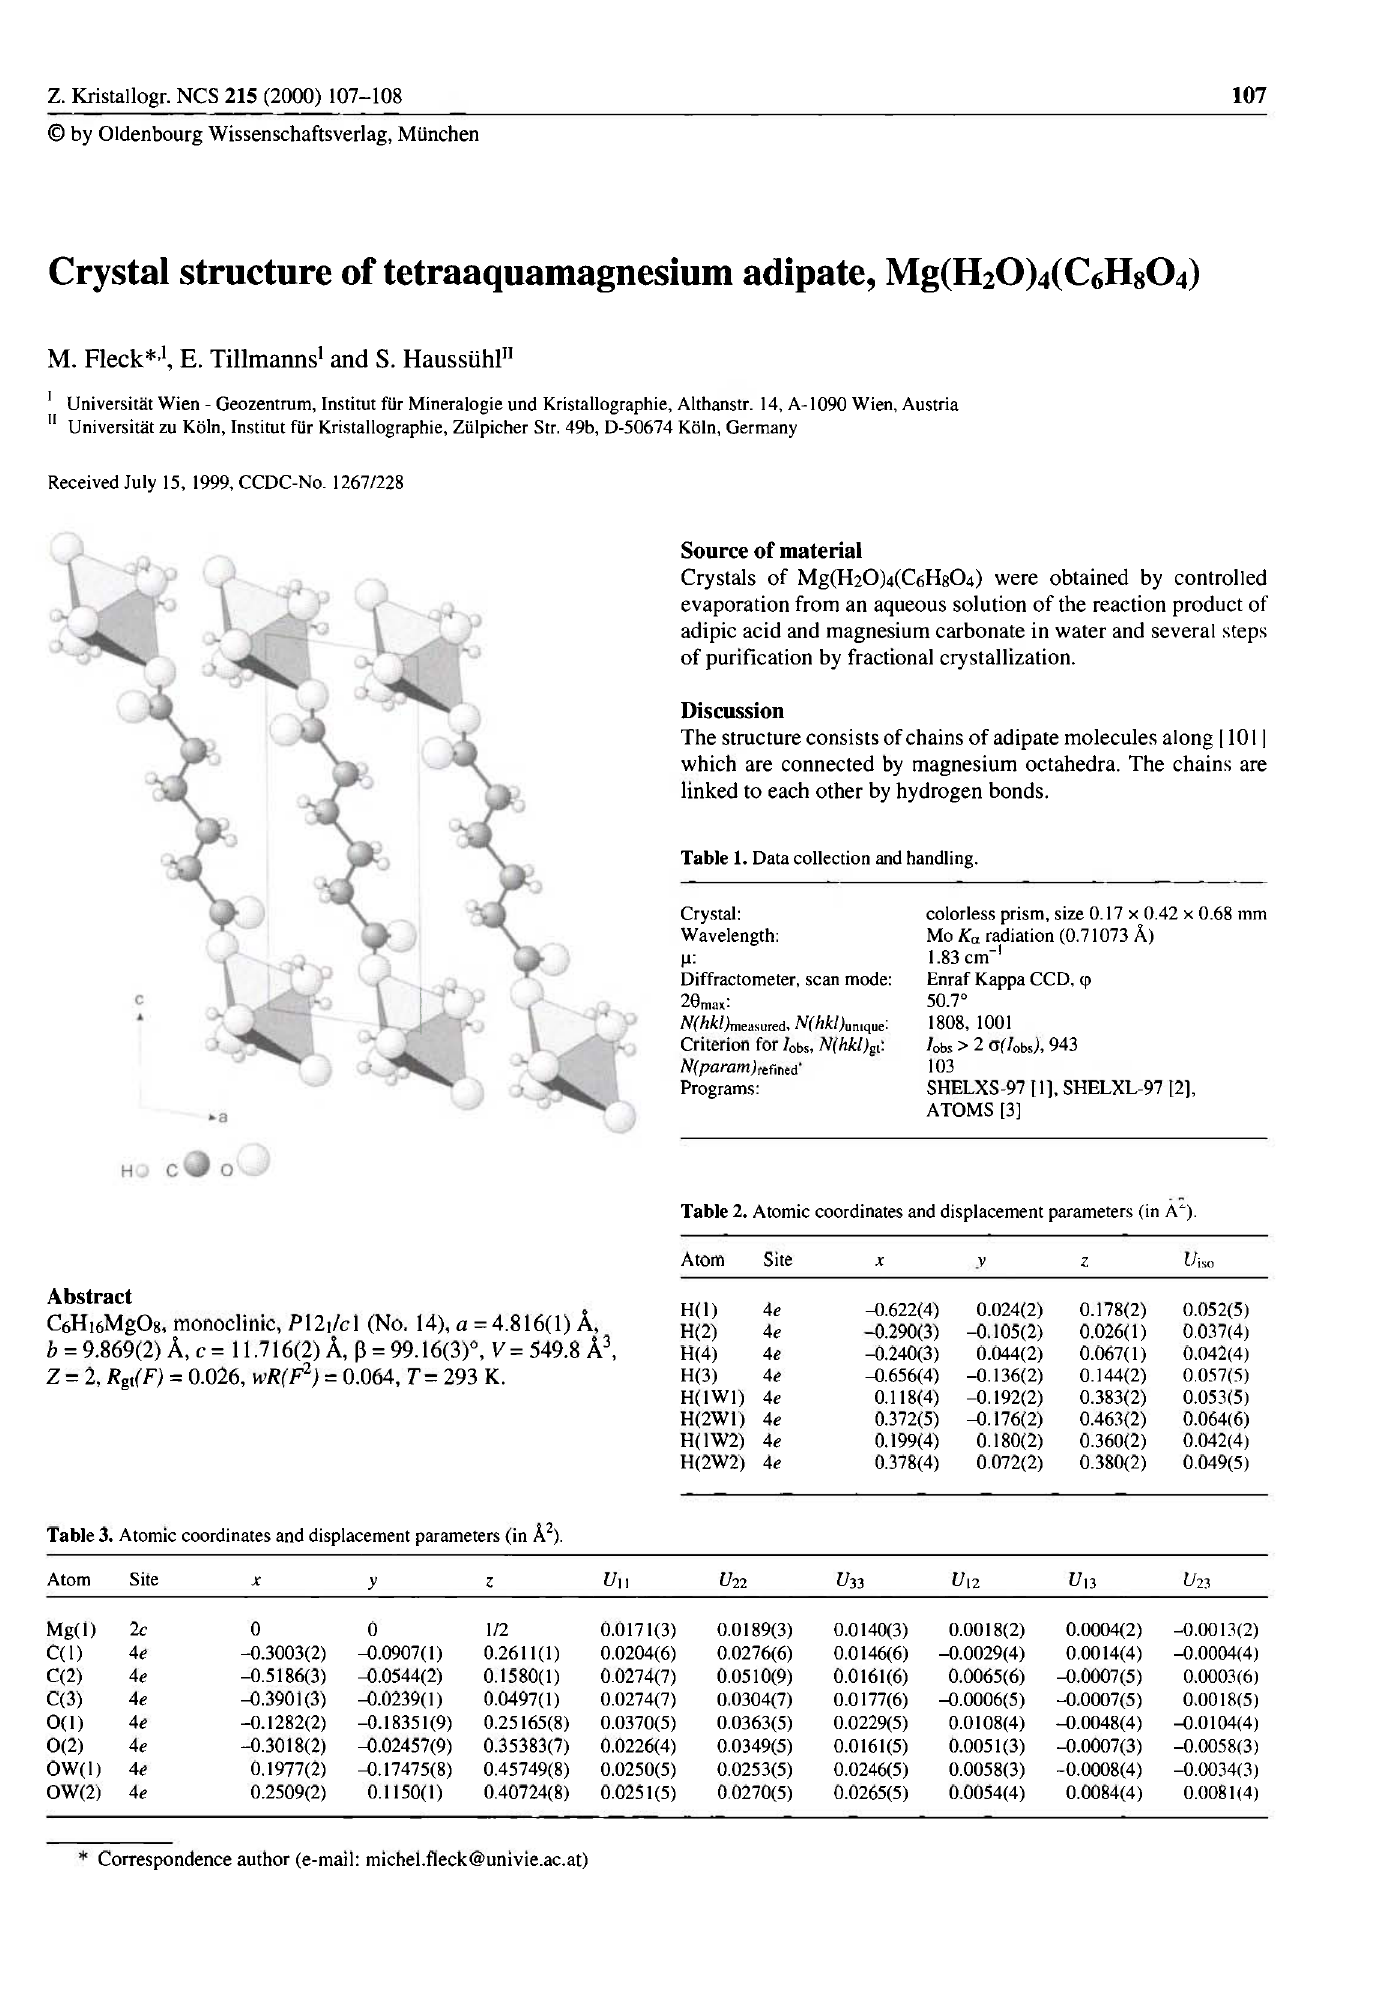
Table 3. Atomic coordinates and displacement parameters (in Ä 2